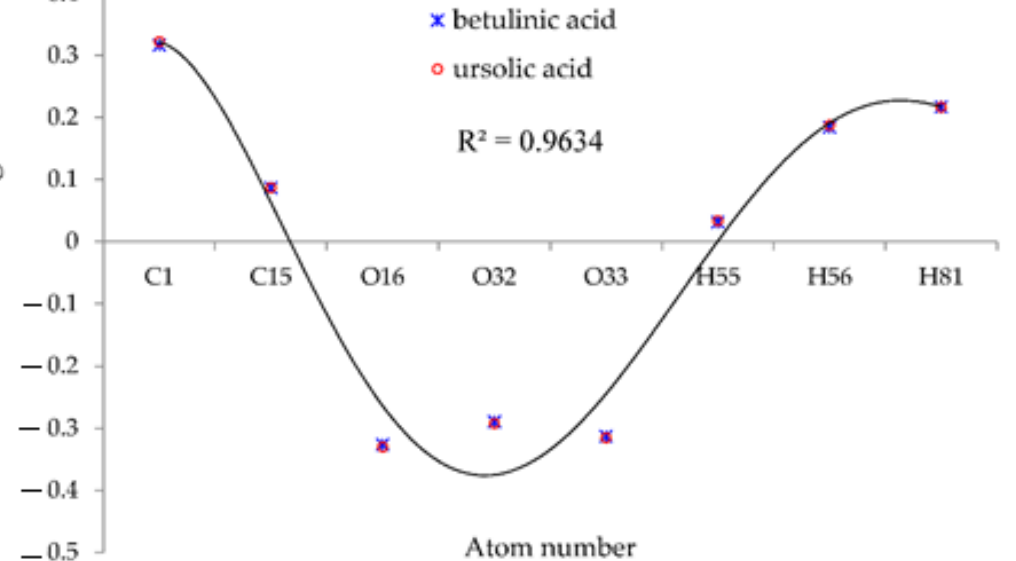
Figure 2. The fluctuation of atomic charge (Q) of hydrogen, carbon and oxygen atoms in the active sites of (+)-catechin, betulinic acid, ursolic acid, quercetin-3-O-galactoside, luteolin-7-O-glucoside, and myricetin.